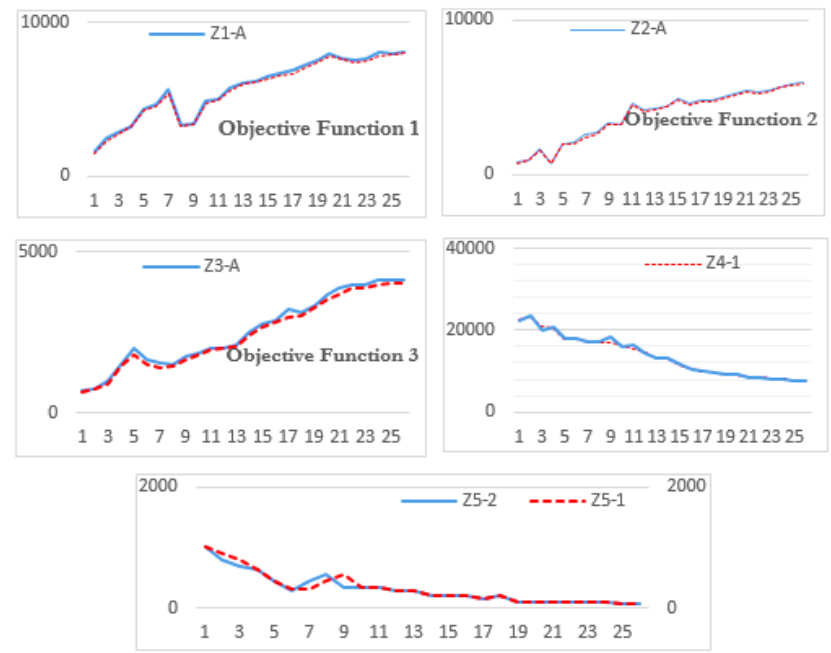
Fig. 5. Comparing the objective functions before and after robustification (UN: before – A: after).